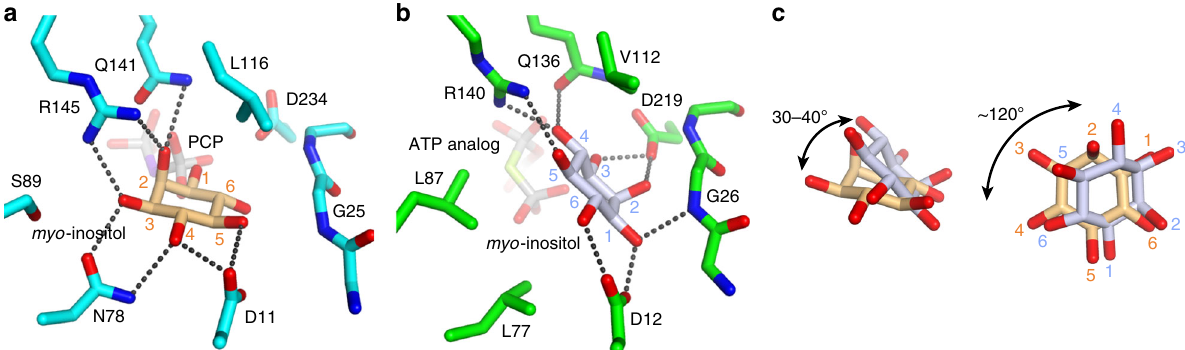
Fig. 4 myo -inositol-binding mode. a , b The myo -inositol-binding sites in the PCP-complex of TM0415 (cyan) and the substrate complex of MI3K_TK (green, PDB ID 4XF7 19 ). Dotted lines represent the interactions between myo -inositol and the residues. The two panels are drawn from the same viewpoint. c Structural superposition of the two myo -inositol molecules bound to TM0415 (light orange) and MI3K_TK (pale blue). Double-headed arrows indicate the rotation of myo -inositol. The two panels are drawn from two different viewpoints. The atom numbering of myo -inositol carbons is shown in the same color in panels a and